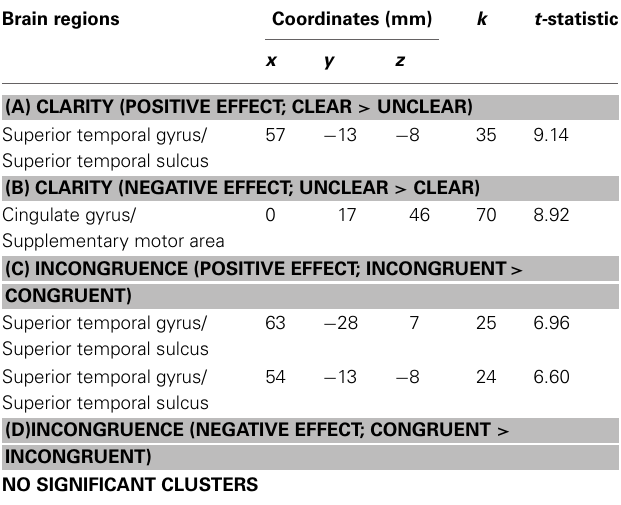
Table 1 | Effects of stimulus clarity and